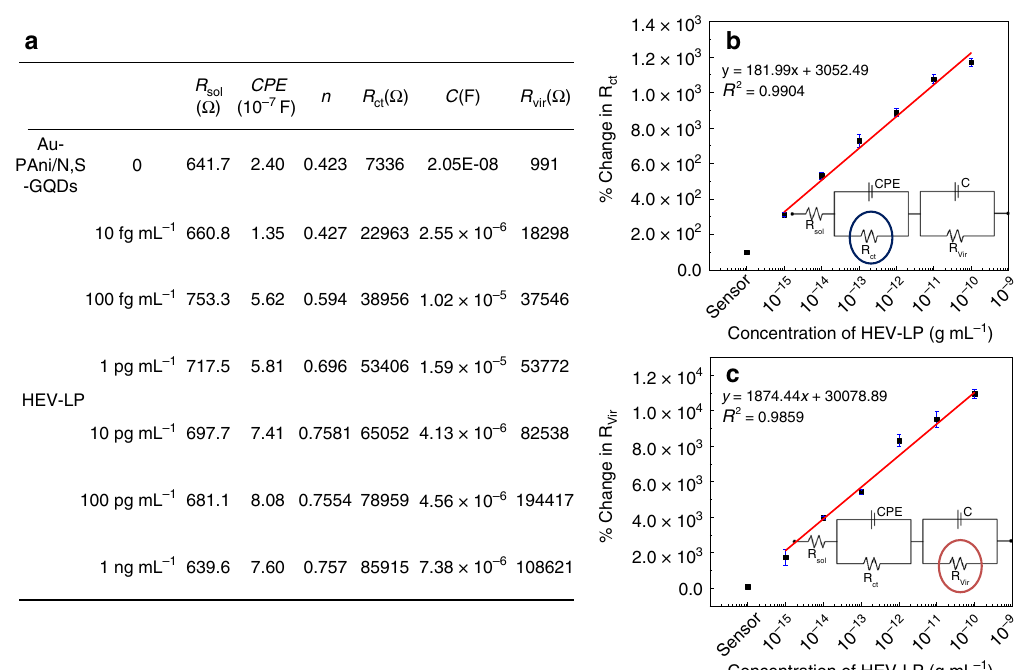
recognize the virus (Supplementary Fig. 7b) compared with the antibody-loaded sensor electrode (Supplementary Fig. 7a). A small increase of impedance has been noticed which may be due to the physical adsorption of the negatively charged viruses on the polyaniline chain (Supplementary Fig. 7b). Without loading of